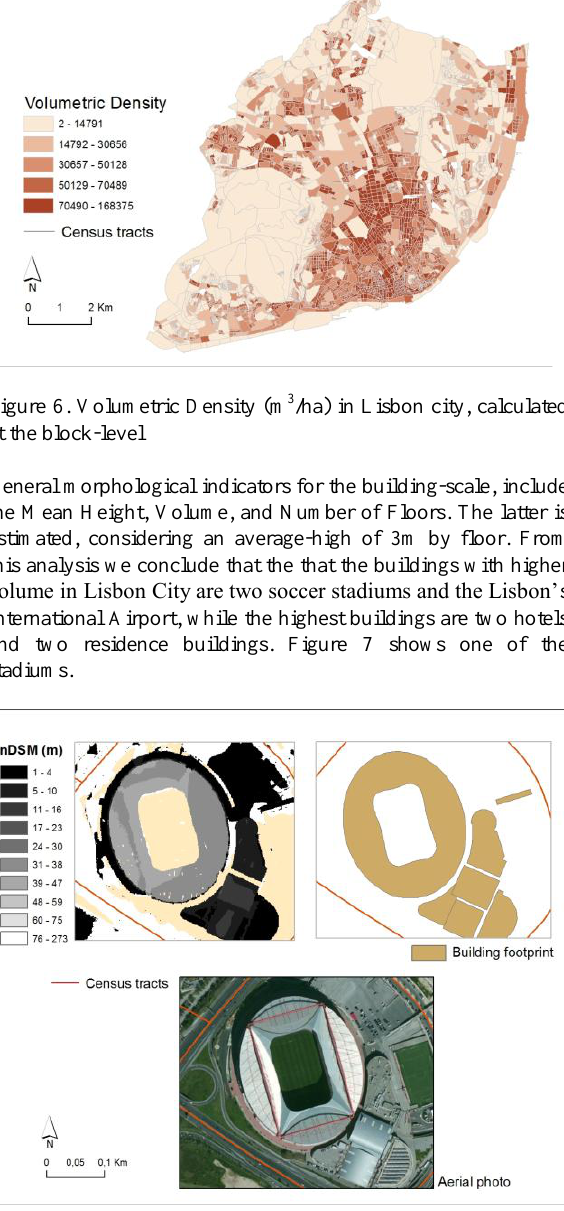
Figure 7. Soccer stadium in Lisbon